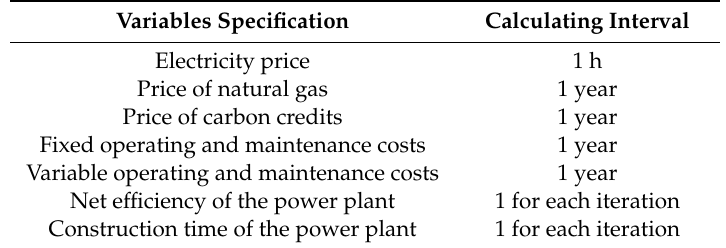
Table 2. Sampling interval in the Monte Carlo simulation for the input